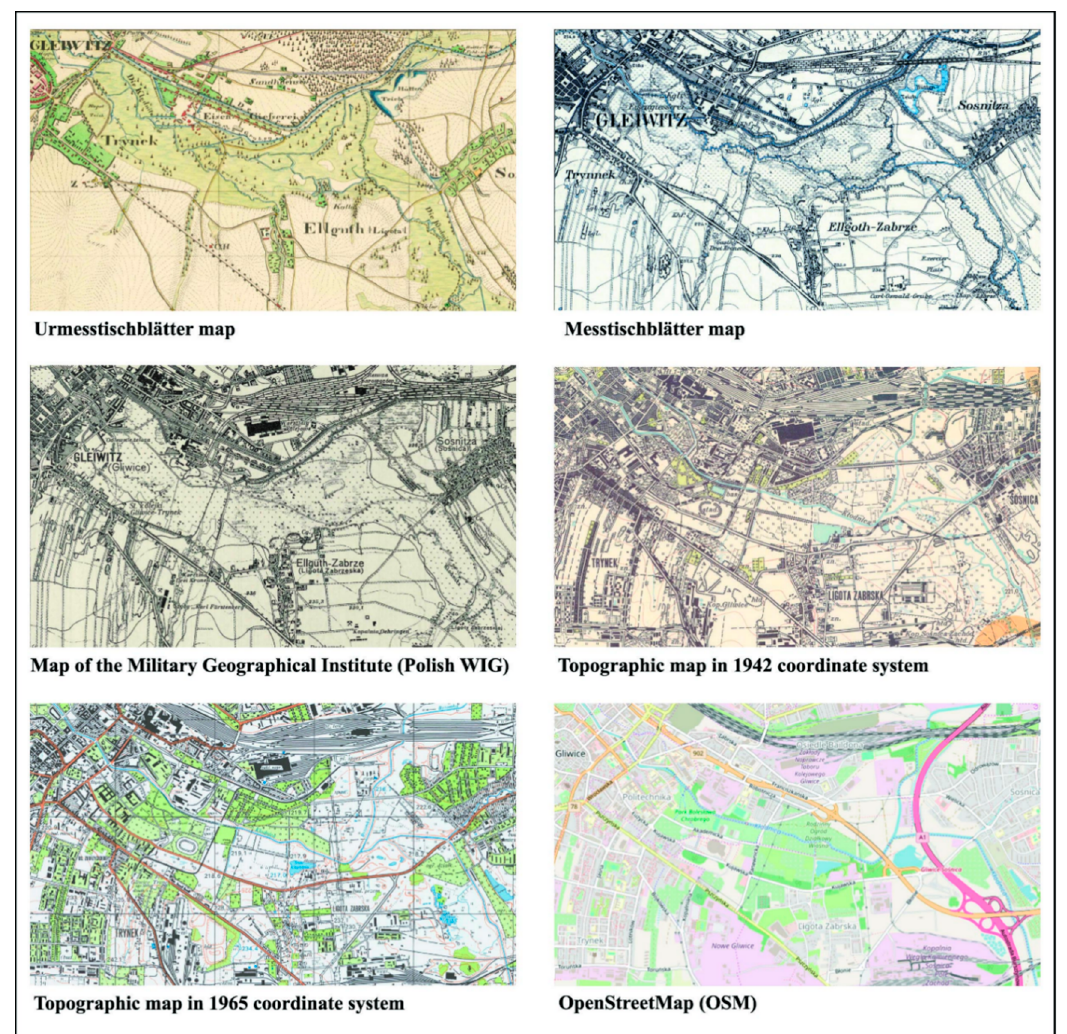
Figure 2. Source materials for the six periods.